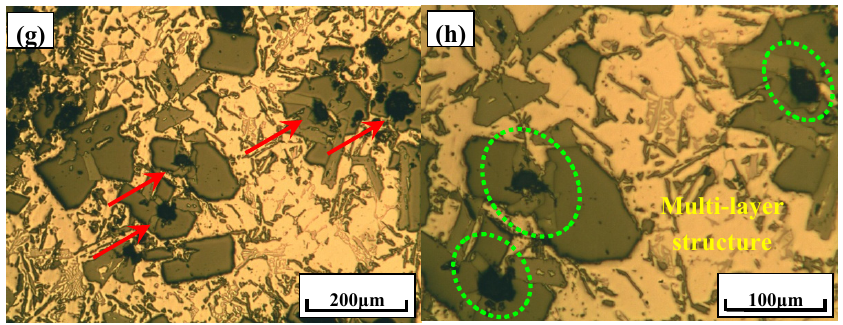
Figure 7. Typical microstructures of Al–xSi–2Ca–3Y–1P alloys: ( a , b ) Al–6Si–2Ca–3Y–1P; ( c , d )